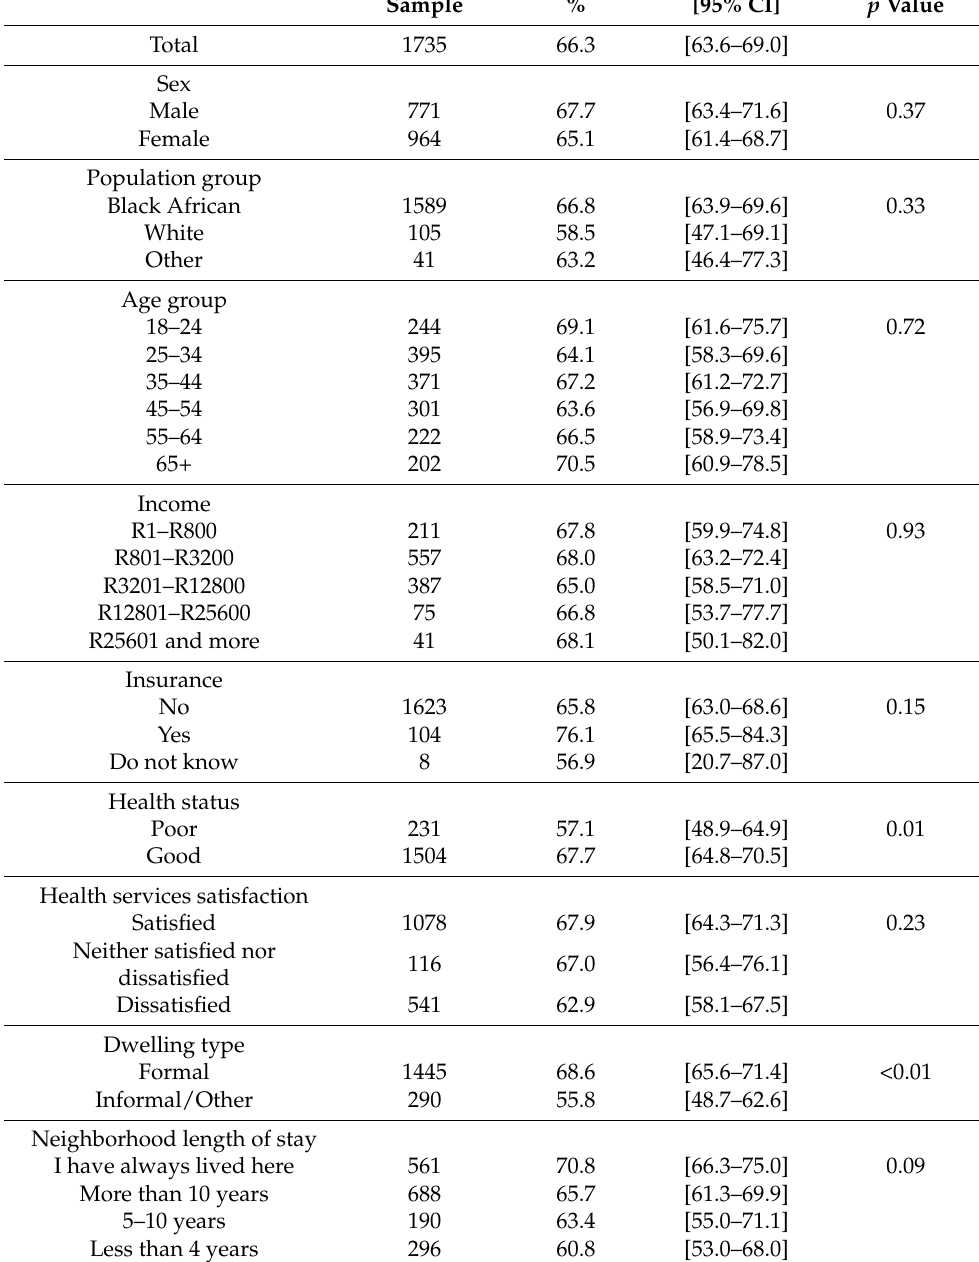
Table 3. Percentage of respondents that reported they had access to public healthcare facilities within their